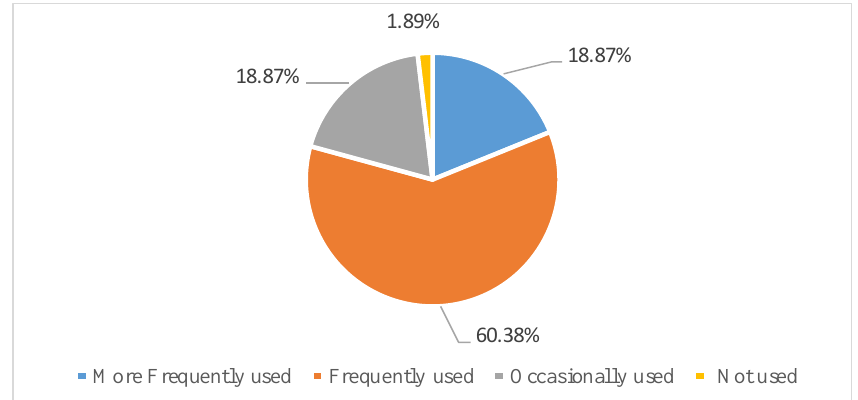
Figure 5. The usage time of students in the platform.